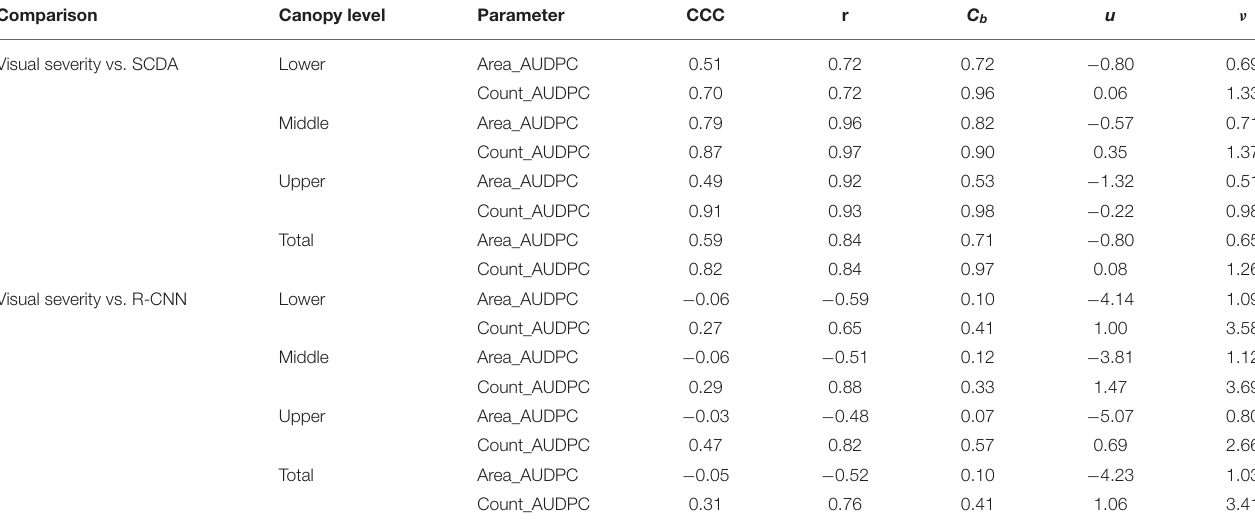
TABLE 3 | Correlation of AUDPC between visual disease severity vs. SCDA and mask R-CNN, respectively, at lower, middle, and upper canopies of the experimental plots.